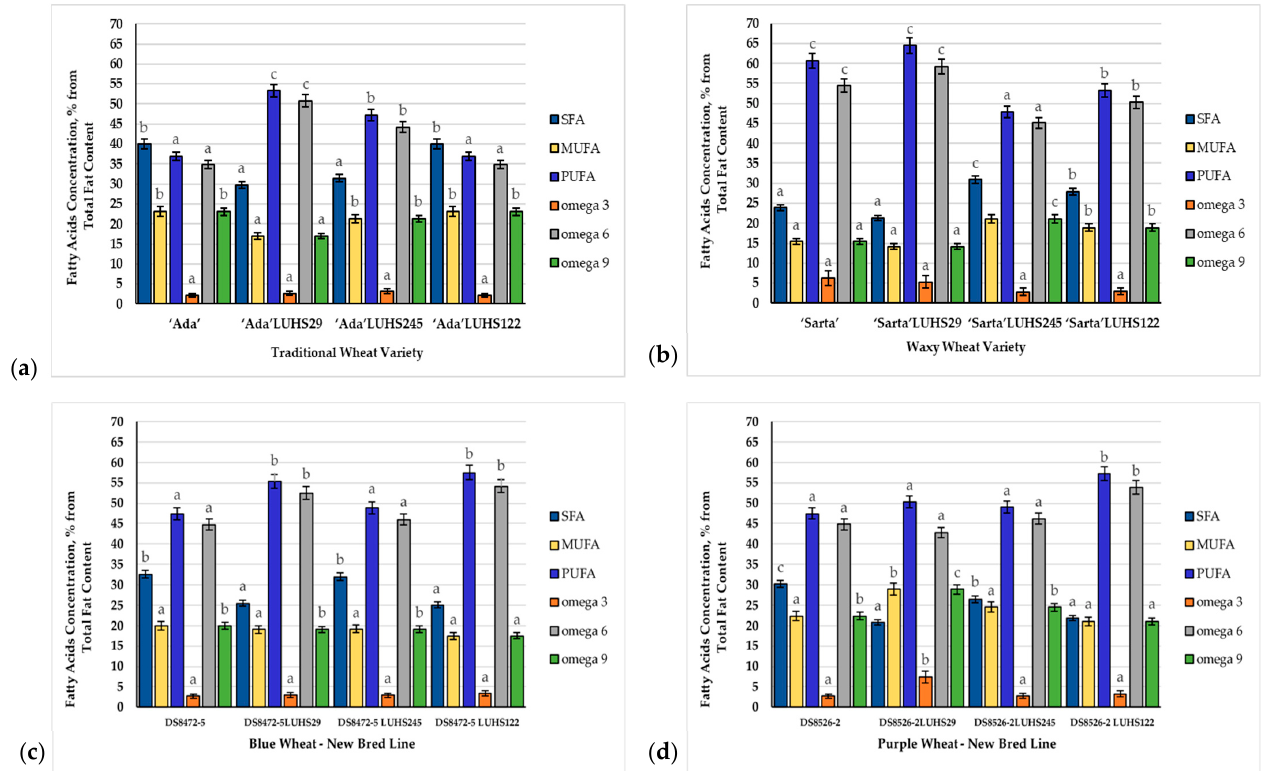
Figure 2. Fatty acid profiles of wheat wholemeal samples: ( a ) Traditional wheat variety fatty acid profile ( b ) Waxy wheat variety fatty acid profile ( c ) Blue wheat—new breed line fatty acid profile ( d ) Purple wheat—new breed line. LUHS29—fermented with Pediococcus acidilactici LUHS29 strain; LUHS245—fermented with Liquorilactobacillus uvarum LUHS245 strain; LUHS122—fermented with Lactiplantibacillus plantarum LUHS122 strain; SFA—saturated fatty acids, MUFA—monounsaturated fatty acids, PUFA—polyunsaturated fatty acids. Data are represented as means ( n = 3) ± SE. a–c Means with different letters in the column are significantly different between the same variety of non-treated and fermented samples ( p ≤